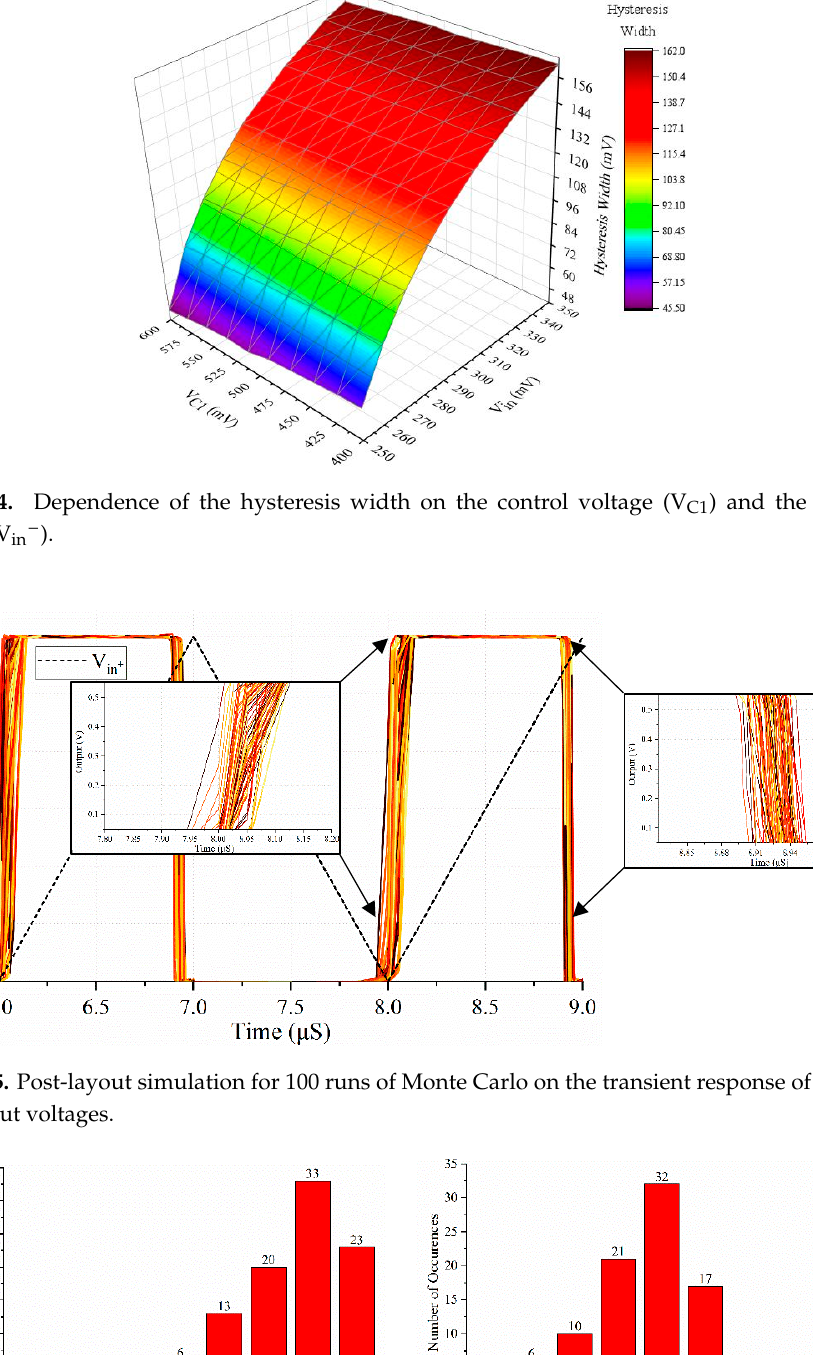
Figure 13. Variation of the hysteresis width and its center versus reference voltage of V in − while V C1 is set to 300 mV.